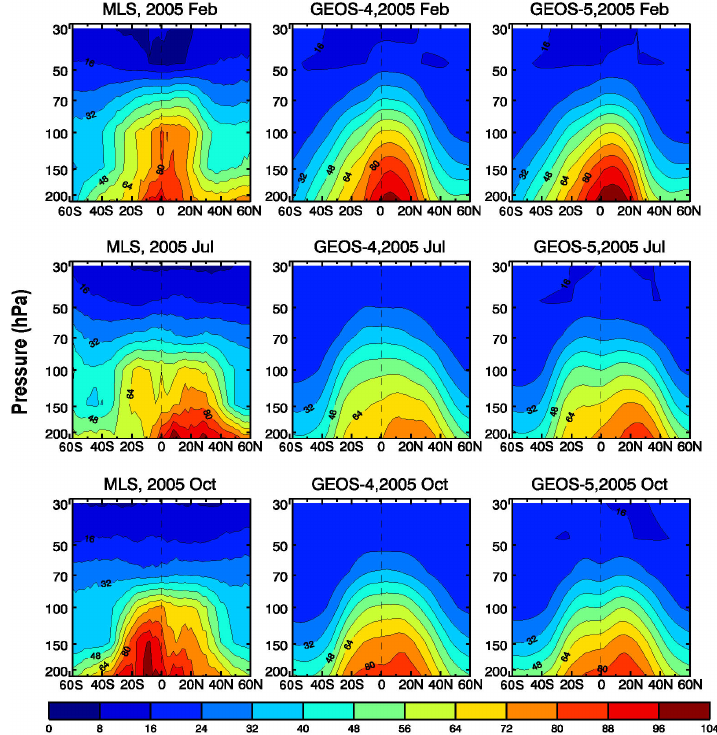
Fig. 4. Pressure-latitude cross-section of zonal mean CO mixing ratios from MLS (left), the GEOS-Chem simulations driven by GEOS-4 (middle) and GEOS-5 (right) using GFED2 emissions with the MLS AKs applied in (top) February, (middle) July and (bottom) October 2005.